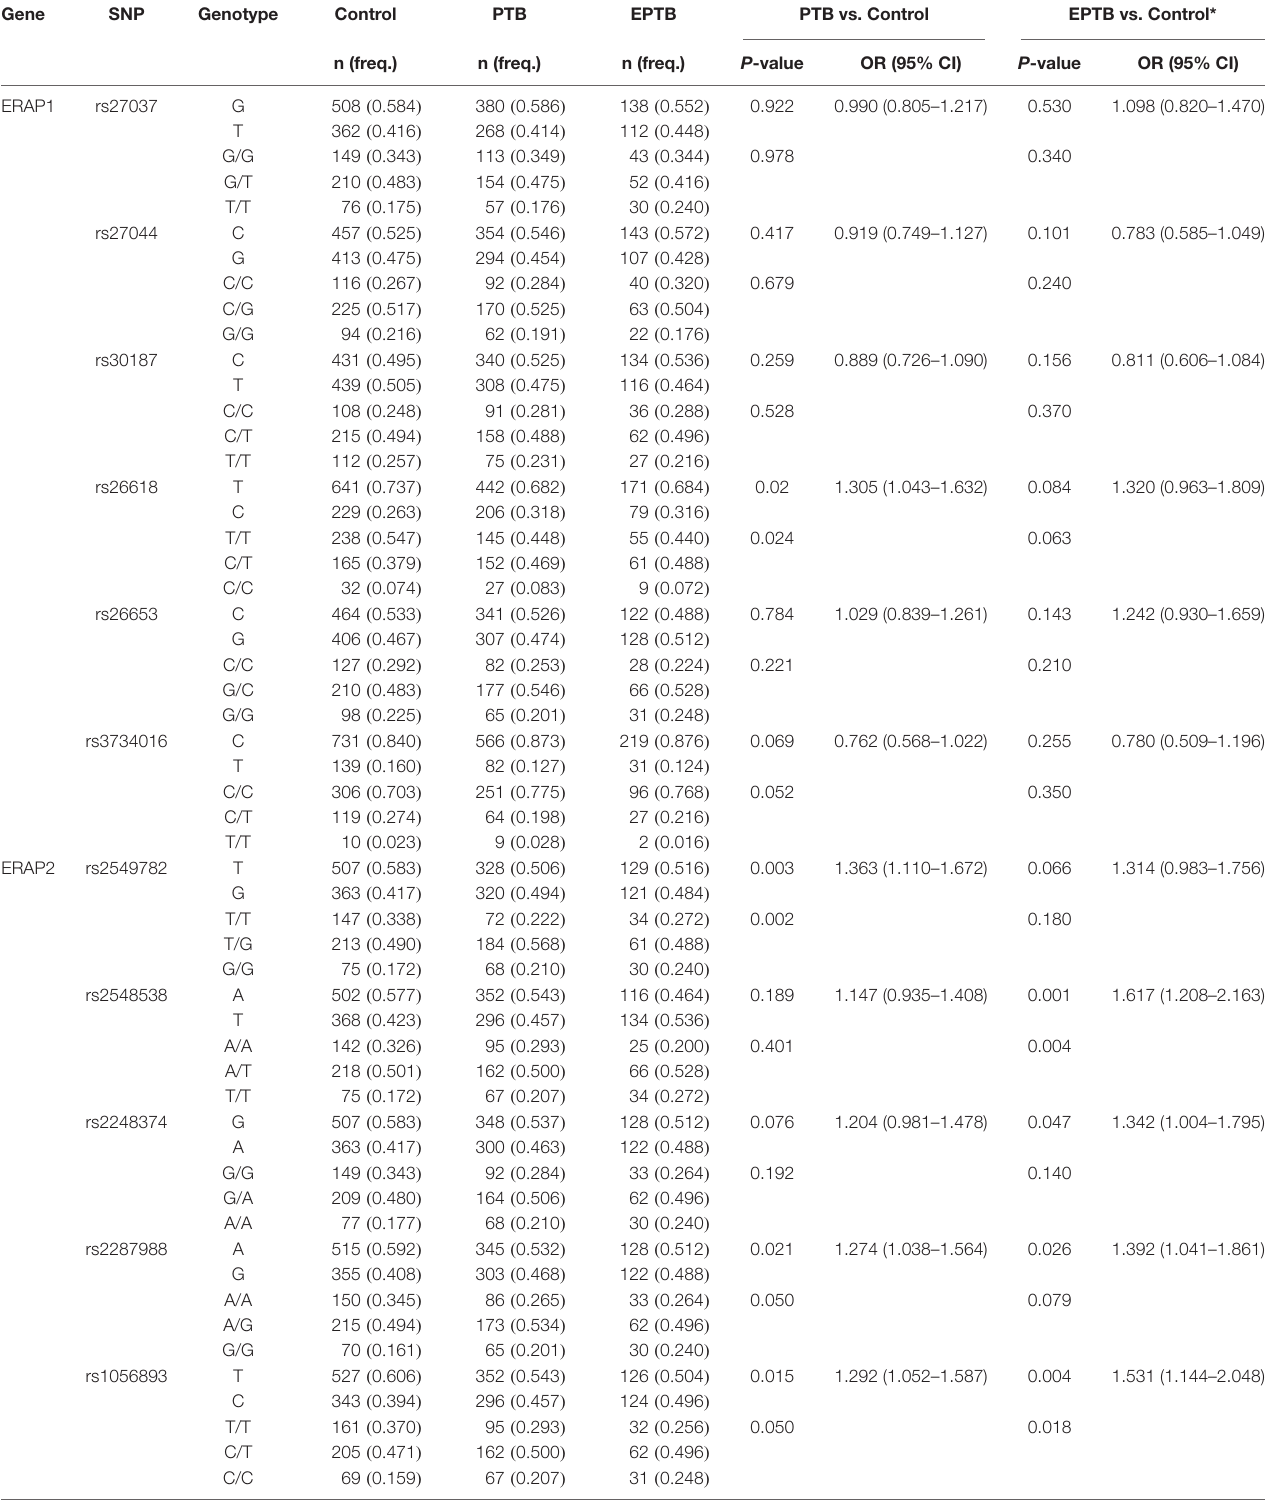
TABLE 5 | The allelic and genotype distribution of ERAP1 and ERAP2 genes among the control, PTB and EPTB groups. Gene SNP